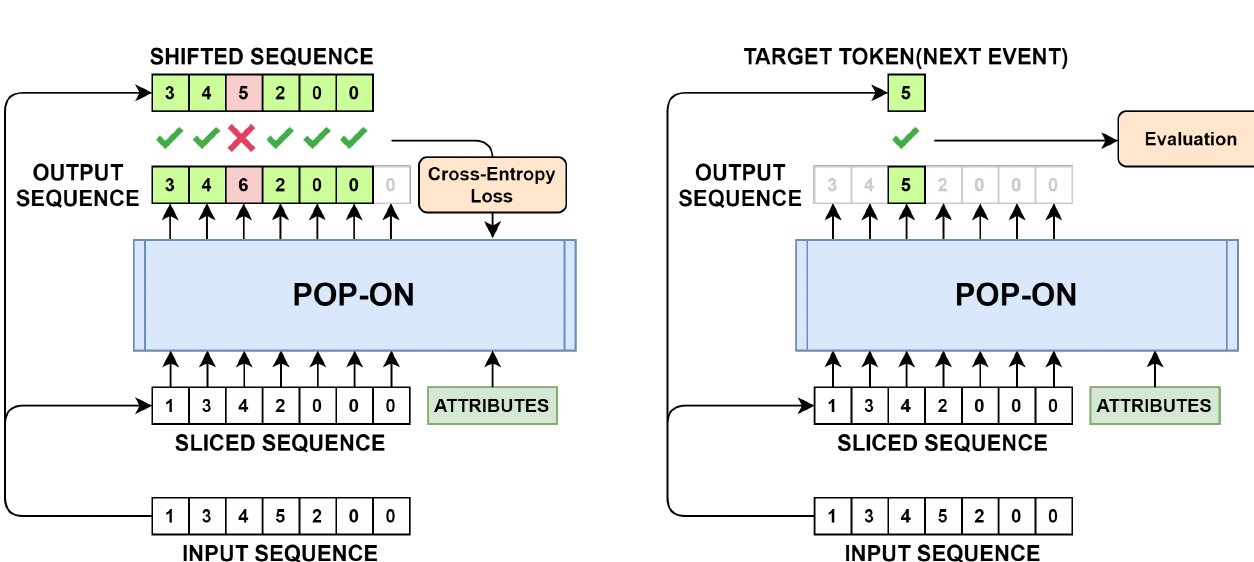
Figure 6. Appearance of the train process and test